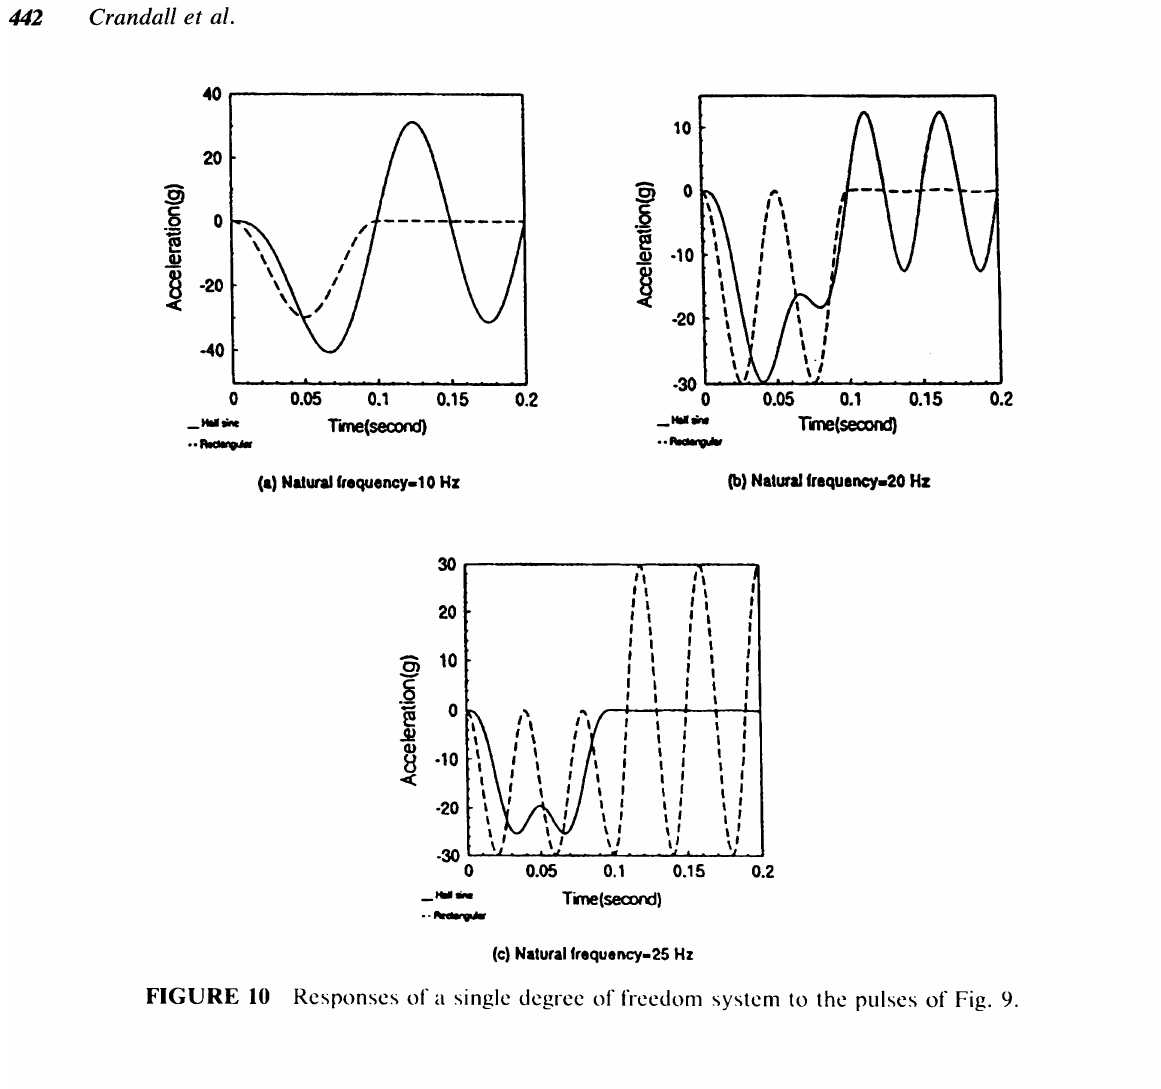
FIGURE to Responses of a single degree of freedom system to the pulses of Fig.